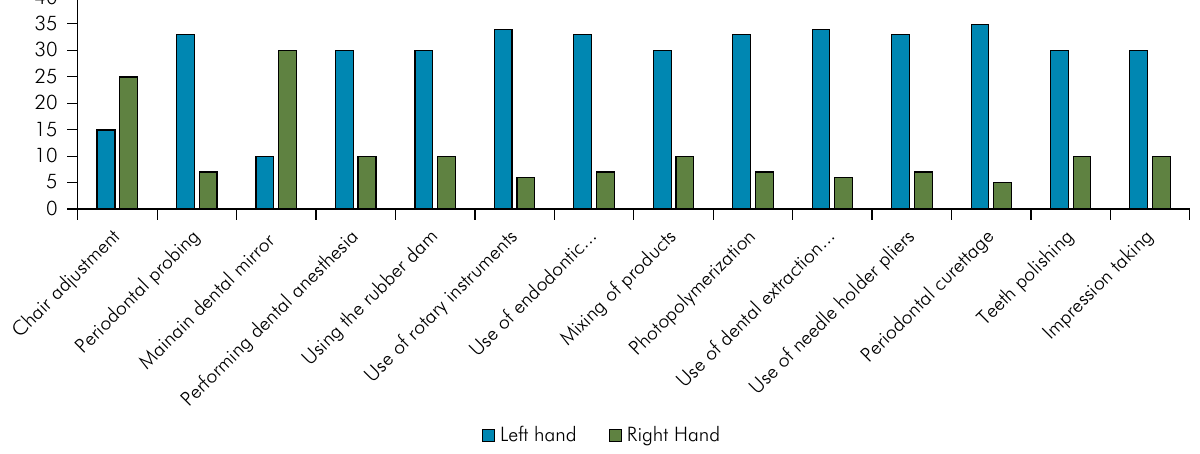
Left hand Figure 1. Percentage of left-handed participants’ responses regarding the hand they used in performing dental procedure.